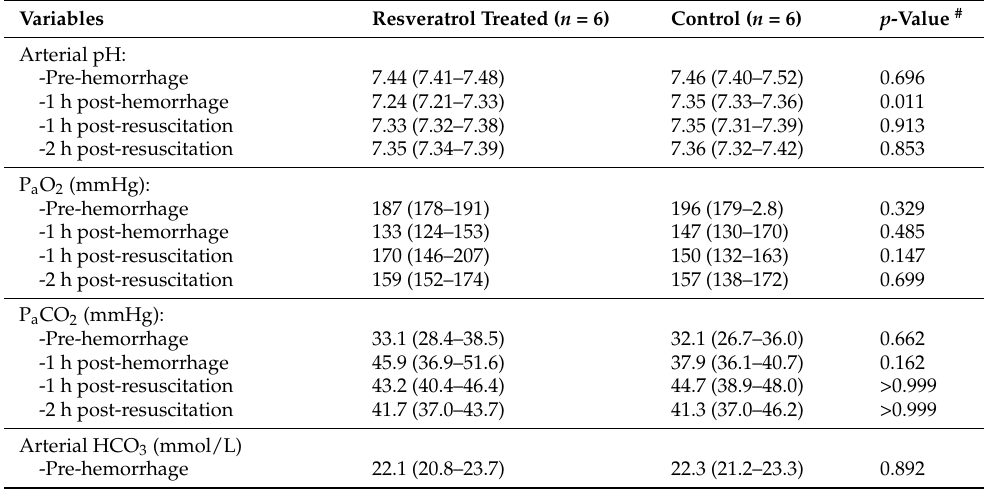
Figure 2. Changes in mean arterial pressure (MAP) over time in anesthetized greyhounds subjected in a pressure-targeted hemorrhage model. Values are median and interquartile range. ( A ) Control group ( n = 6). ( B ) Resveratrol pretreated group ( n = 6). Table 4. Arterial and venous blood gas parameters during the experiment ( n =